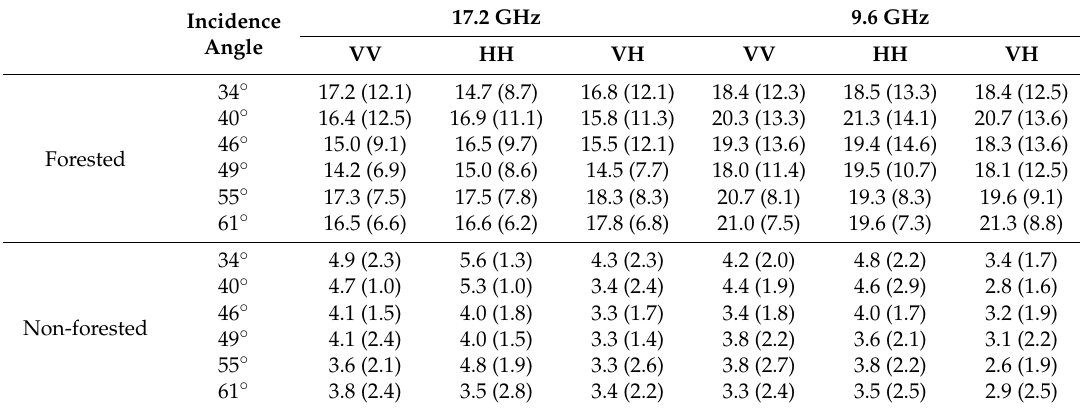
Table 3. The mean number of inflection points from range profiles.